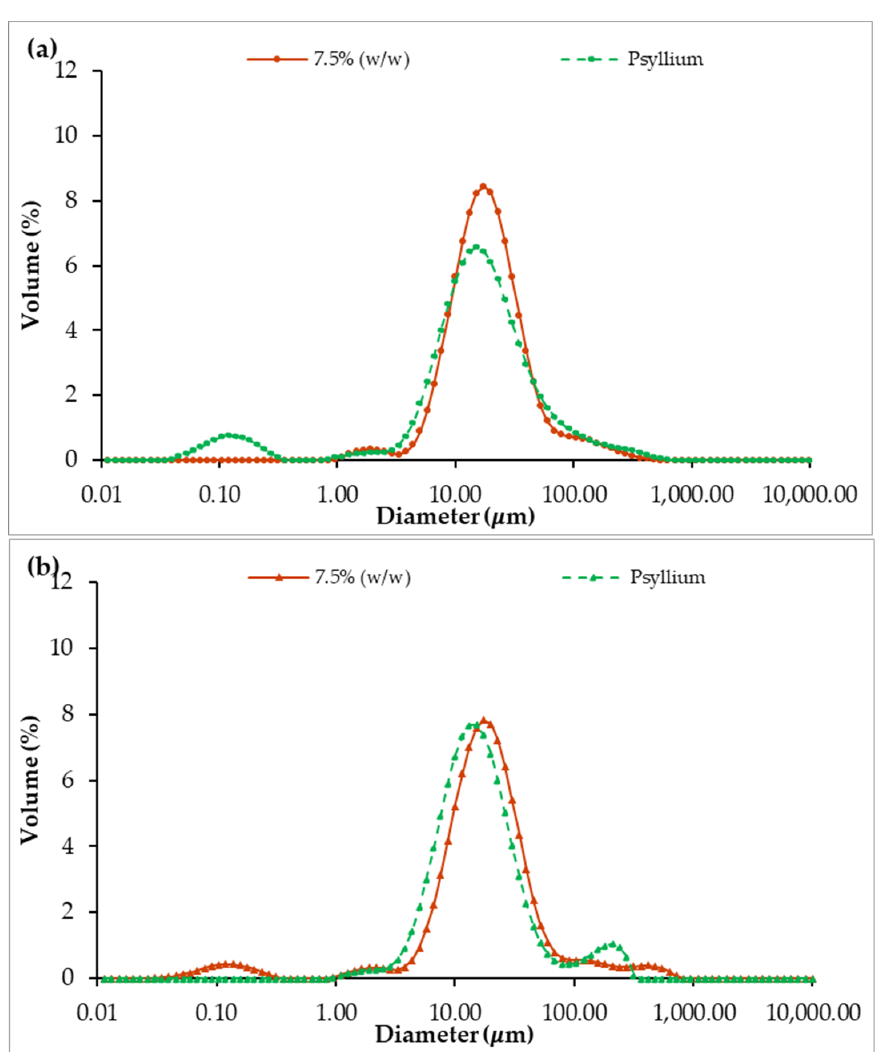
Figure 12. Comparison of droplet size distribution of emulsions with 7.5% ( w / w ) of miso paste, one of them with 0.1% ( w / w ) of psyllium husk, measured 1 ( a ) and 30 ( b ) days after emulsion preparation.